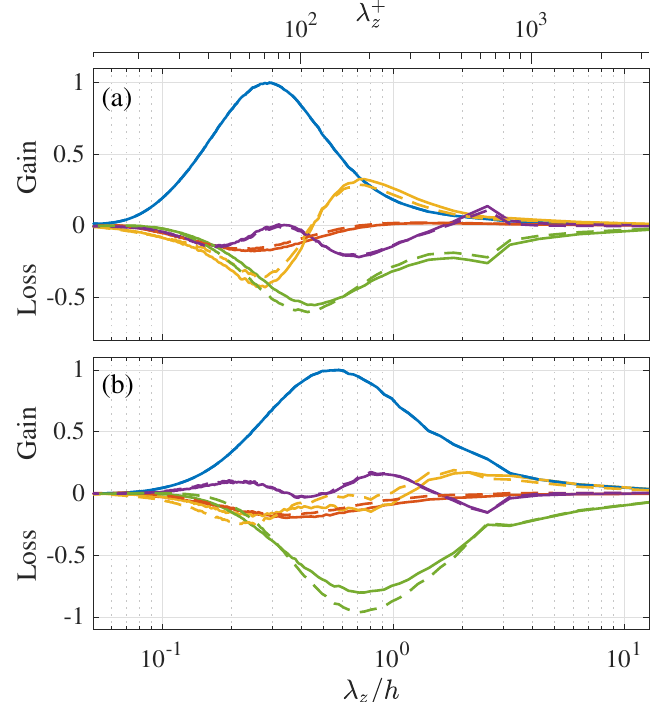
Figure 14. Detailed budget balance of the E z − and E z − uv transport equation at ( a ) a near-wall location v θ y + = 16 and ( b ) the quarter height of the channel y / h = 0.25 presented in the same manner as in Figure 11: (blue) production; (red) viscous dissipation + viscous diffusion; (yellow) interscale transport; (purple) turbulent diffusion; (light green) pressure